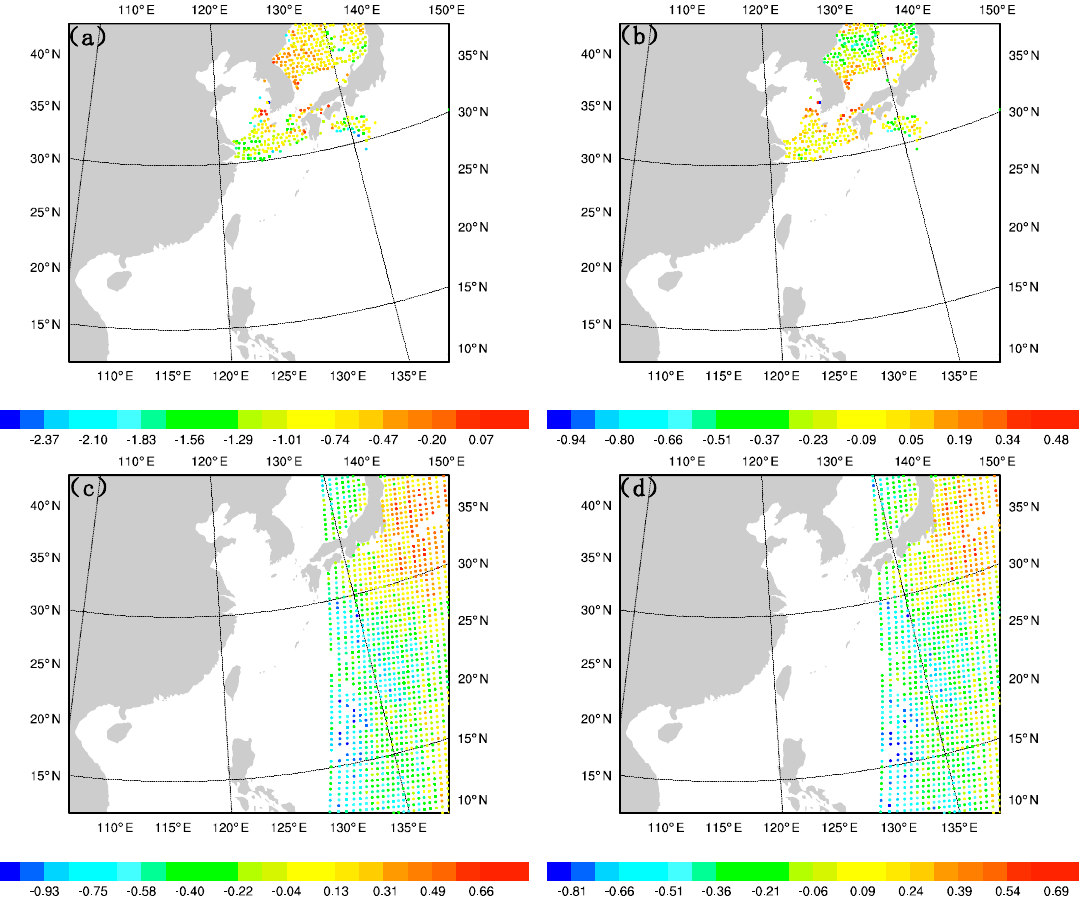
Figure 4. ( a ) observation of the brightness temperature minus the simulated brightness temperature in the background field (OMB; unit: K), and ( b ) observation of the brightness temperature minus the simulated brightness temperature in the analysis field (OMA; unit: K) of channel 1382 from the Atmospheric Infrared Sounder (AIRS) and ( c ) OMB (unit: K), and ( d ) OMA (unit: K) of channel 9 from the National Oceanic and Atmospheric Administration (NOAA) 15 Advanced Microwave Sounding Unit-A (AMSU-A) after bias correction at 1800 UTC on 9 July 2015.